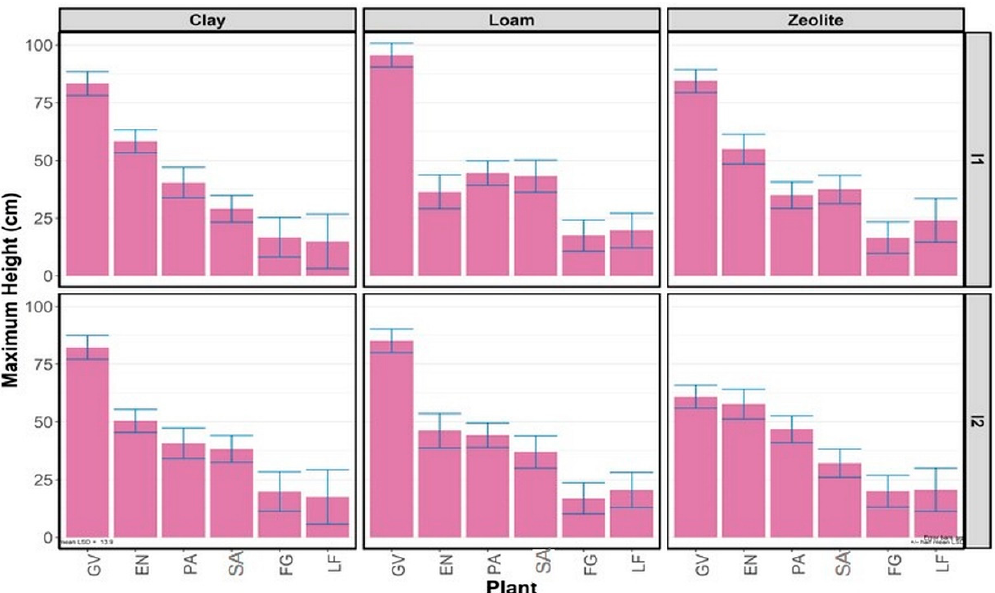
Figure 4. Predictions of H max for plants in di ff erent substrates and irrigation treatments. Error bars are approximately ± 0.5 LSD (5%); if they do not overlap, the predicted means are significantly di ff erent ( p ≤ 0.05), while those whose error bars overlap are not significantly di ff erent ( p > 0.05).